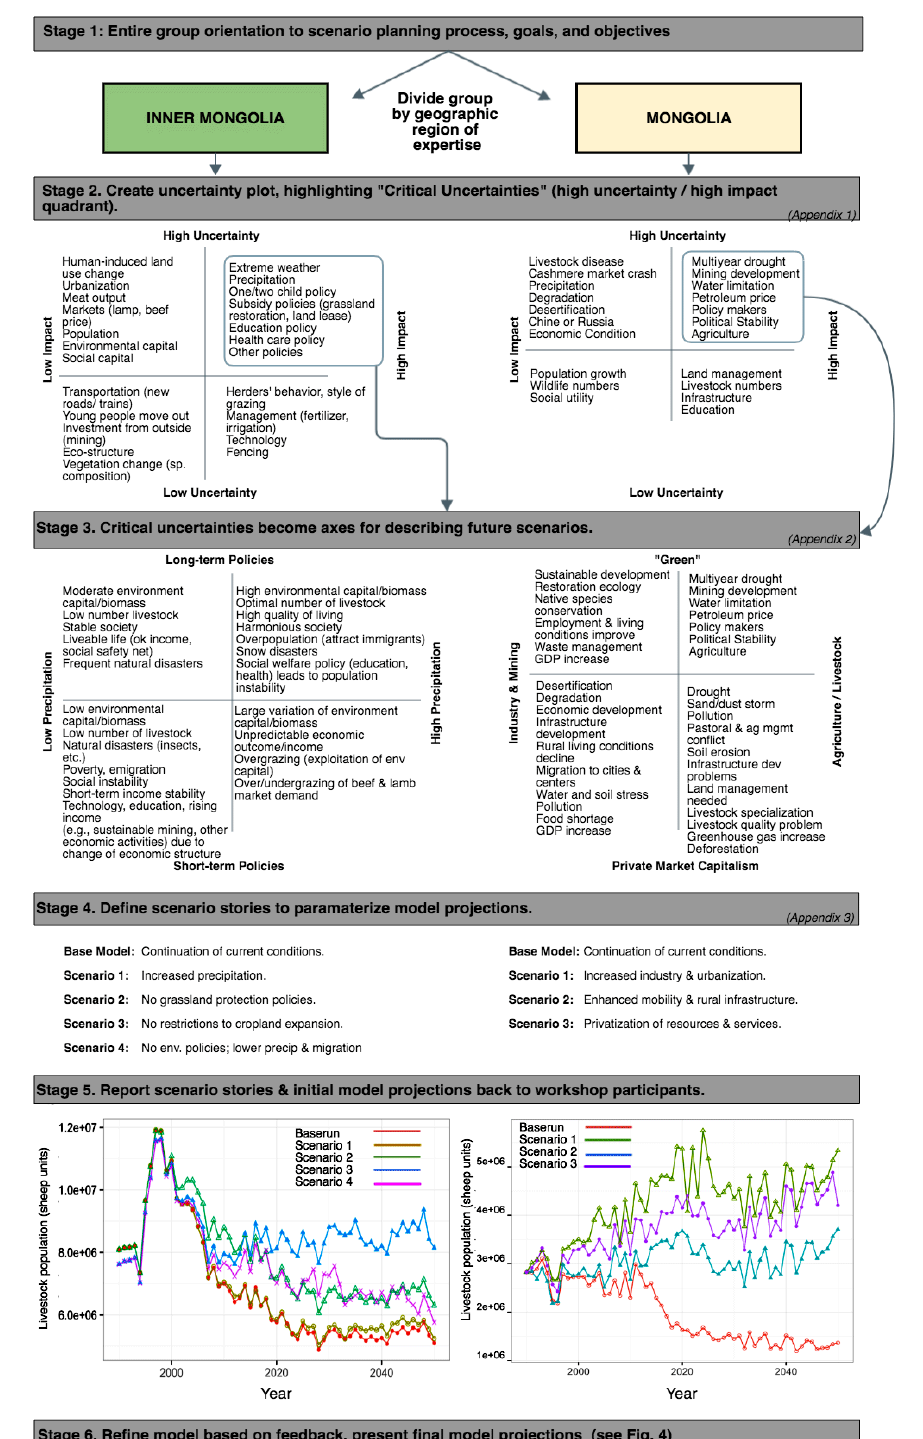
Fig. 2 . Work flow to articulate scenario stories for use in model simulation, example from Inner Mongolia group. In Stage 2, participants ranked drivers along axes of uncertainty and impact. The High Uncertainty/High Impact quadrant represents the “critical uncertainties,” which are then used to formulate the axes for generating future scenarios in Stage 3. We utilized the scenario stories from Stage 3 to identify parameters for model projections in Stage 4. In Stage 5, initial model projections based on interpreted scenario stories were presented back to workshop participants for